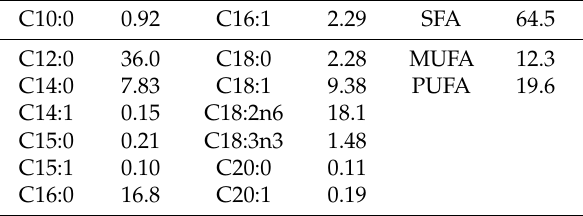
Table 3. Fatty acid profile (g / 100 g total fatty acids - TFA) of BSF larvae fed with brewer’s